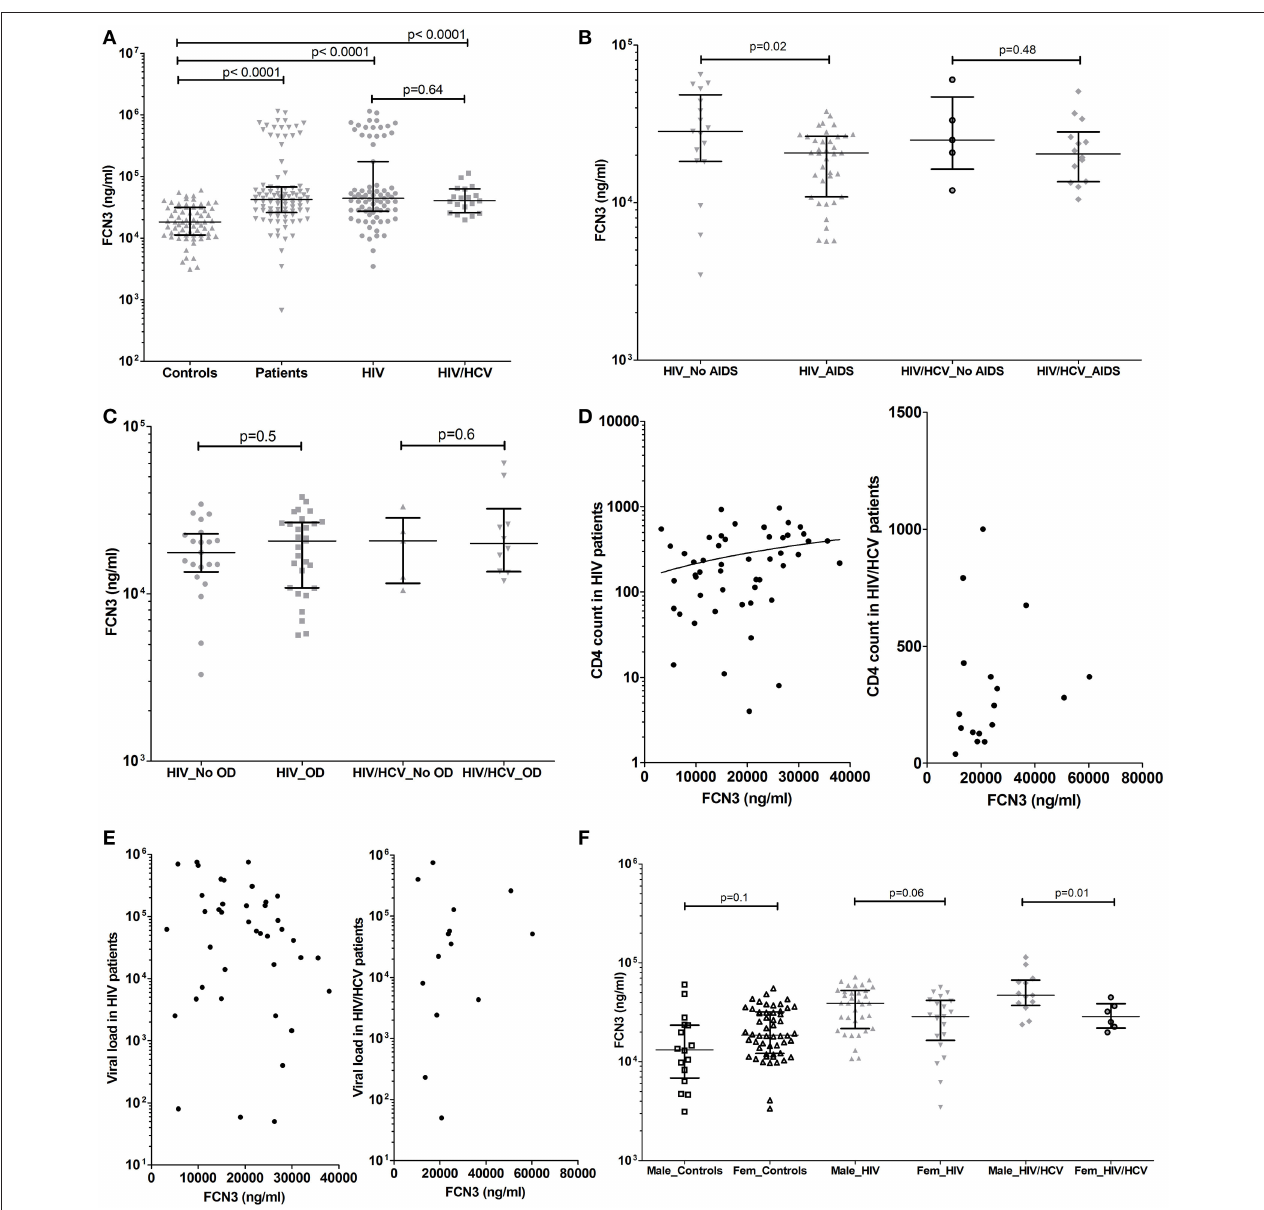
FIGURE 2 | Ficolin-3 plasma levels in controls, HIV patients and HIV/HCV coinfected patients (A) , considering the presence of AIDS (B) and opportunistic diseases (C) . Correlation between Ficolin-3 and T CD4 cell counts (D) , Ficolin-1 and HIV viral load (E) (Values are in Log10 scale) in HIV and HIV/HCV patients. Ficolin-3 levels in male and female controls and patients (F)